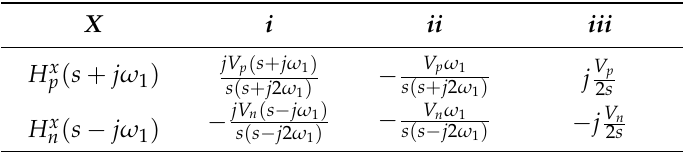
Table 1. Detailed expressions of H x p ( s ) and H x n ( s ) in Equation (3) with different implementations of the adaptive PR current